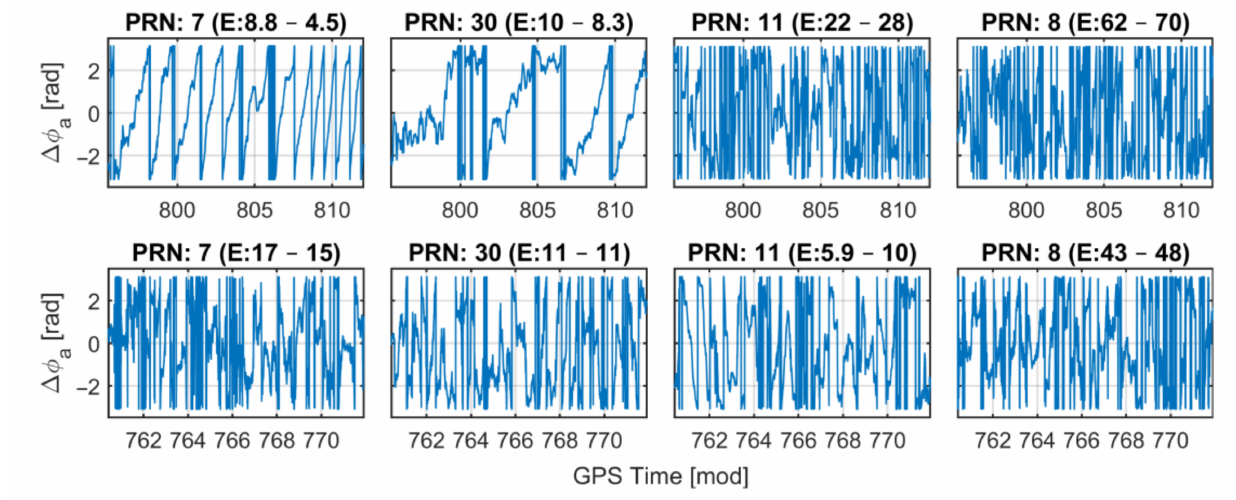
Figure 10. Observed residual phase angle of the retracked signal for PRN 7, 30, 11, and 8 on 2 different days. The first row is on 17 July 2019, and the second row is on 15 July